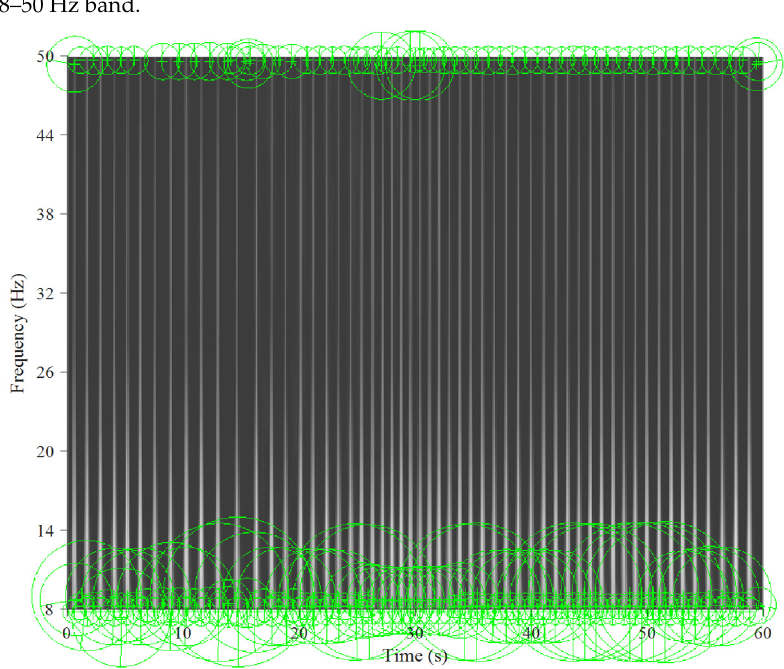
Figure 6. Key points extracted from the sleep apnea ECG spectrogram for a 60 s window and 8–50 Hz band.